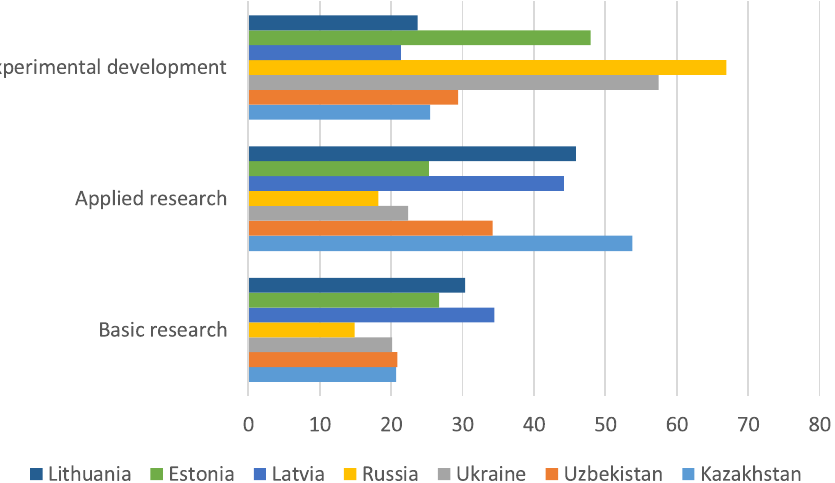
Figure 12. Research and development expenditures by type of research in 2018 (or late available). Data sourced from